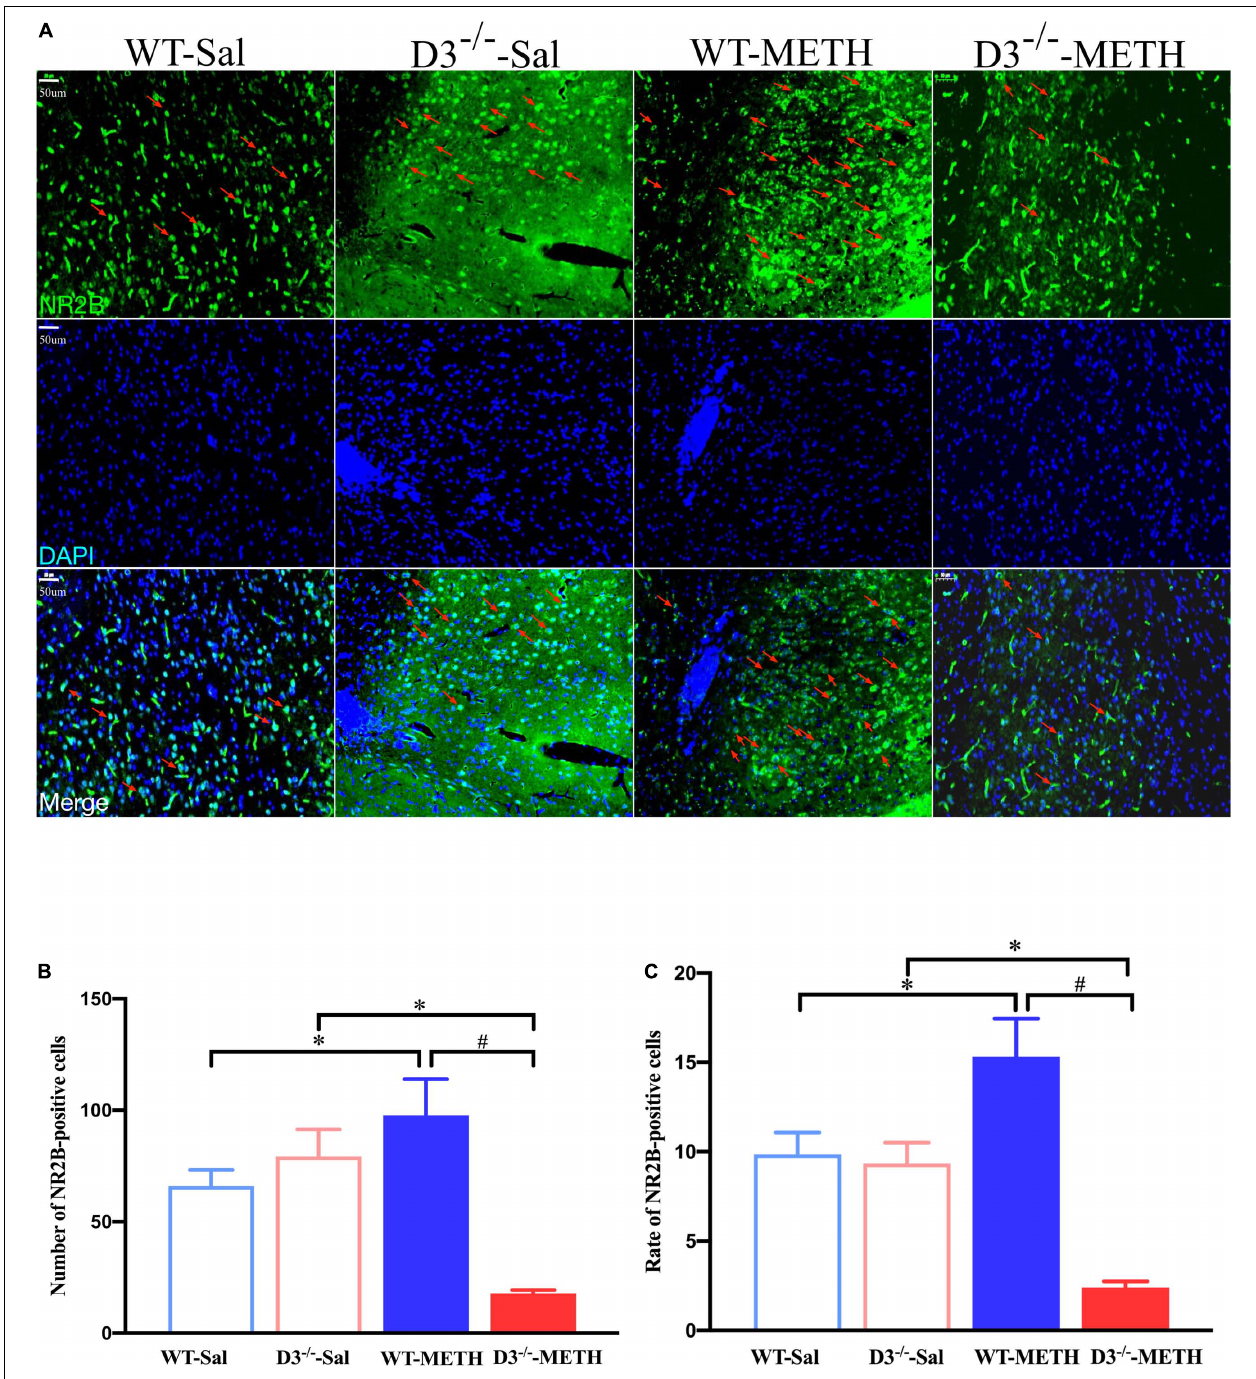
FIGURE 7 | Knockout of dopamine D3 receptor gene blocked the changes of glutamate NR2B-positive cells in the NAcsh of METH-sensitized mice. (A) Fluorescent staining of the glutamate NR2B in the NAcsh. The red arrows indicated the glutamate NR2B-positive cells. Scale bars = 50 µ m. (B,C) Quantification of the number (B) and rate (C) of glutamate NR2B-positive cells in the NAcsh of the four groups of mice ( n = 3 mice each). ∗ P < 0.05 compared with the same genotype in saline group; # P < 0.05 compared with same-dose WT mice. Values are presented as mean ± SEM. WT, wild type.